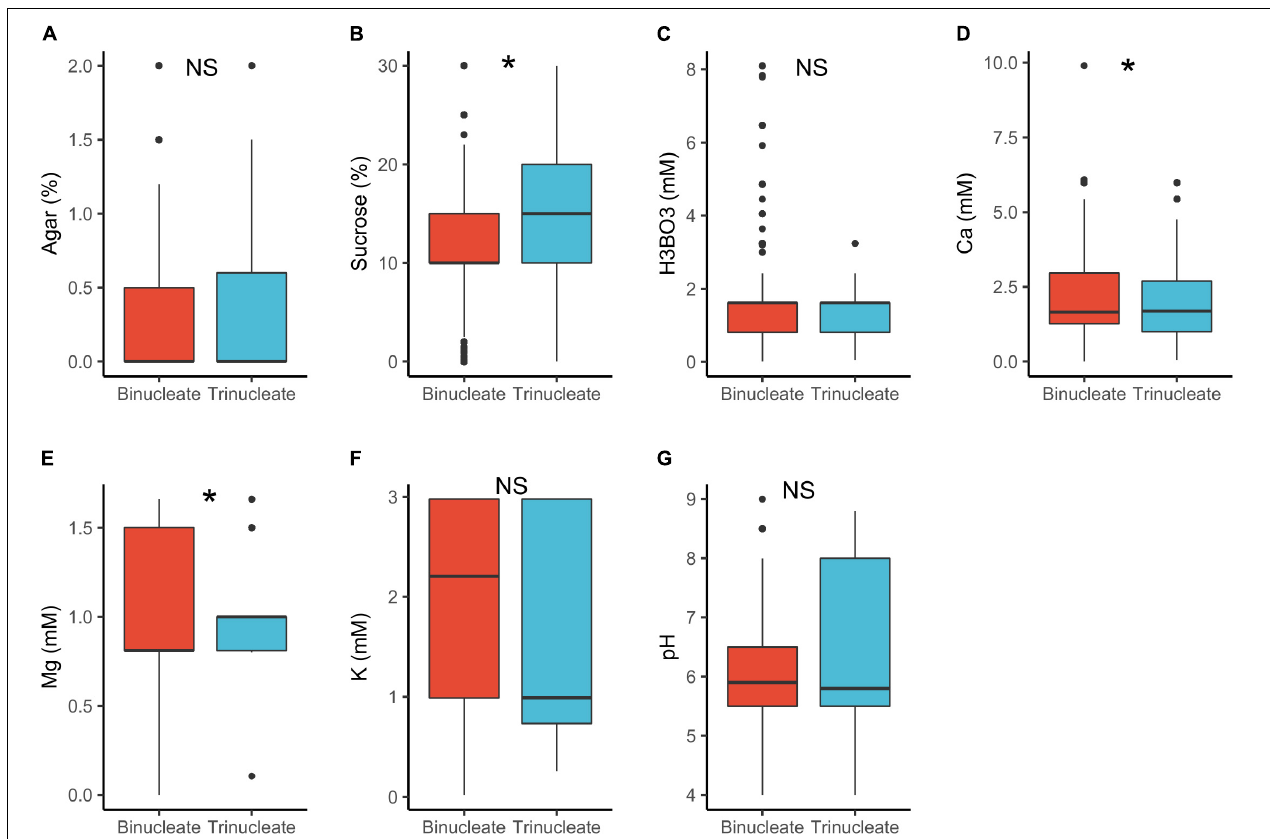
FIGURE 4 | Pollen germination media requirements for binucleate ( n = 913) and trinucleate pollen ( n = 713): agar (A) , sucrose (B) , boric acid (C) , calcium (D) , magnesium (E) , potassium (F) , and pH (G) . *, significant ( p < 0.05); NS, not significant.